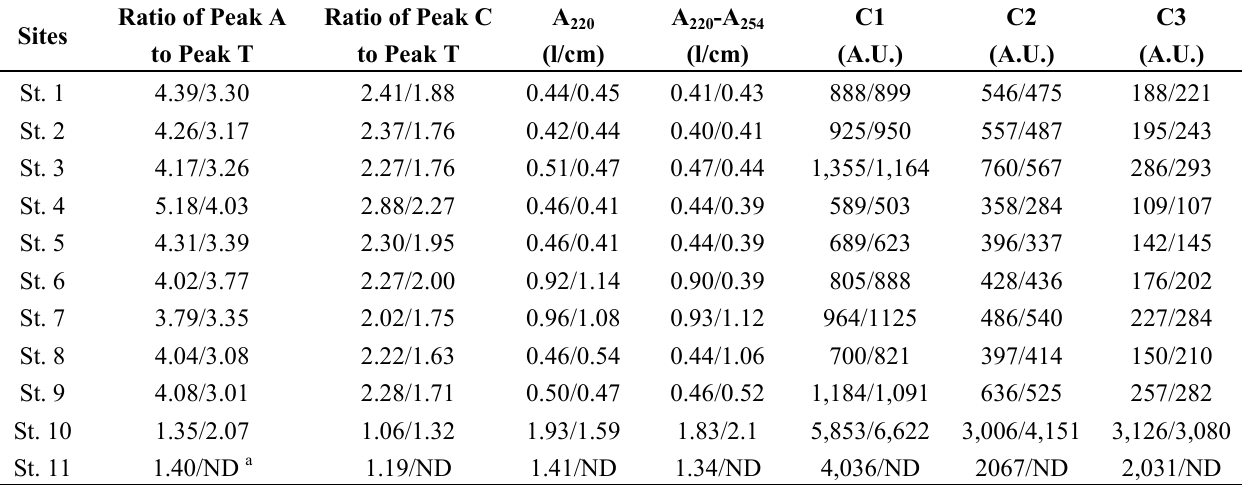
Table 2. Selected spectroscopic characteristics of the river water for this study (September/October) a